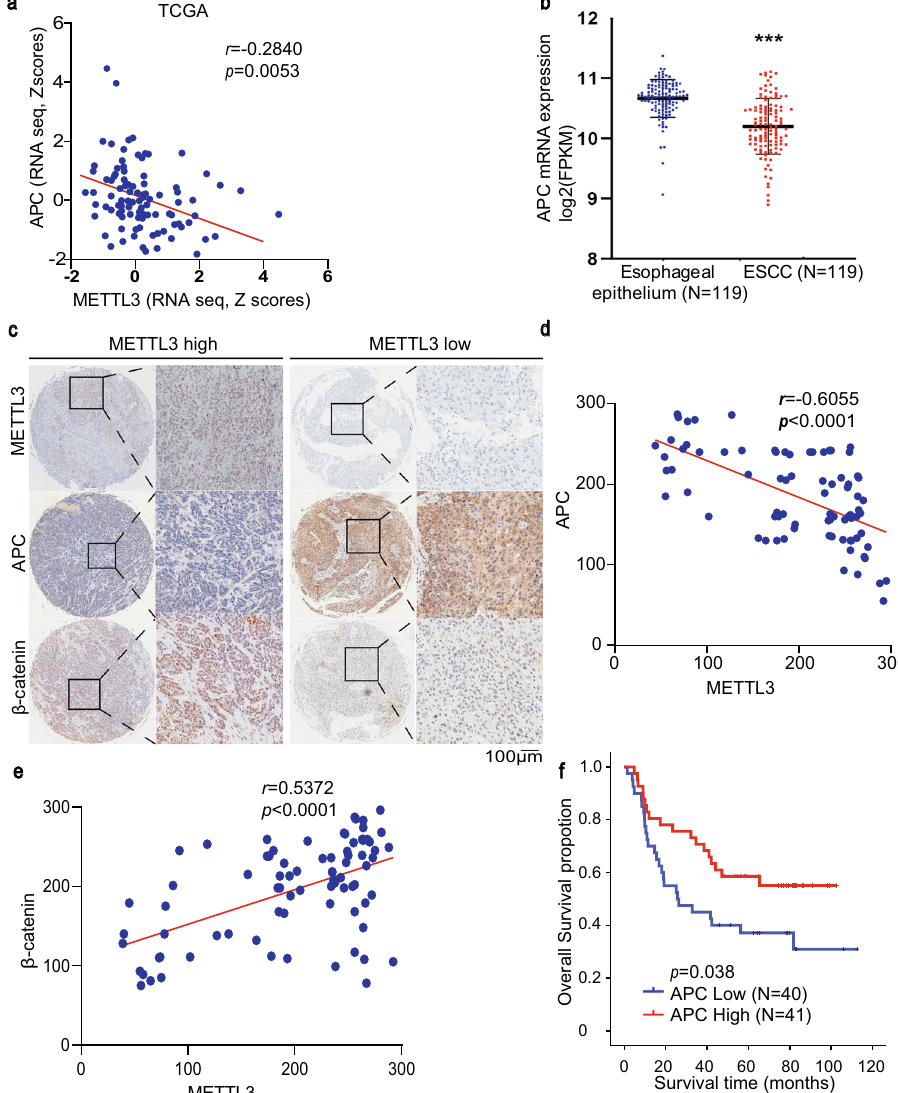
Fig. 7 Downregulated APC expression correlates with upregulated METTL3 expression in human ESCC specimens and poor survival of ESCC patients. a The correlation between the mRNA levels of METTL3 and APC in ESCC of TCGA was analysed by the two-tailed Pearson correlation coef fi cient. b The relative mRNA expression levels of APC were analysed in 119 paired ESCC tissues and their adjacent normal tissues (from the GSE53625 dataset). Data represent the means ± SD of 119 samples. *** p = 1.75E − 15 based on two-tailed and paired Student ’ s t -test. c IHC staining of 81 ESCC specimens was performed with the indicated antibodies three times with similar results. Representative images of METTL3, APC and β -catenin expression levels in two cases of ESCC are shown. Scale bar, 100 μ m. d The correlation between the expression levels of METTL3 and APC in 81 ESCC specimens was analysed by the two-tailed Pearson correlation coef fi cient. p < 0.0001. e The correlation between the expression levels of METTL3 and β -catenin in 81 ESCC specimens was analysed by the two-tailed Pearson correlation coef fi cient. p < 0.0001. f Kaplan – Meier plots of the overall survival rates of human ESCC patients ( n = 81) with high and low expression of APC. p -Values were calculated using the two-tailed log-rank test. Source data are provided as a Source Data fi